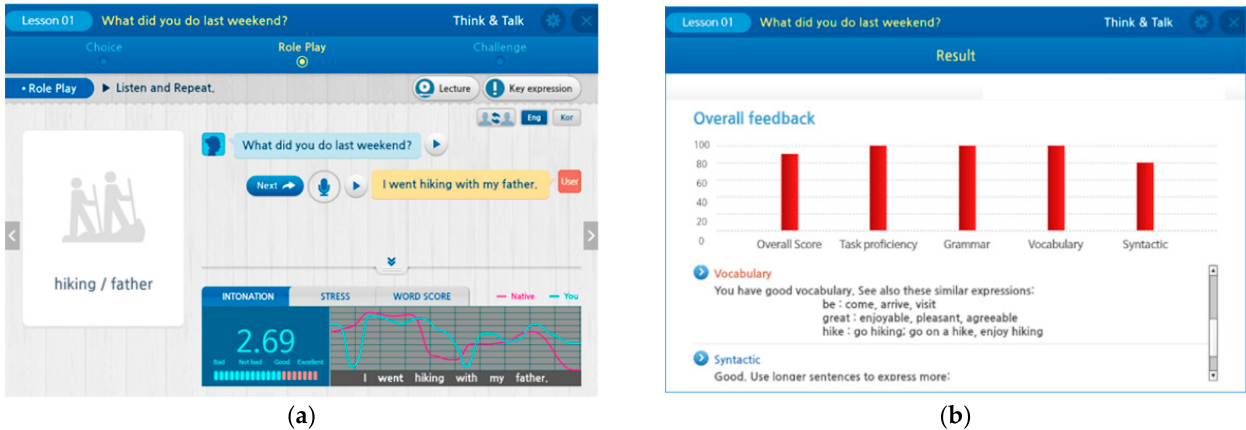
Figure 2. Example of a role-play scenario and the overall feedback. ( a ) Example of a role-play dialogue exercise and intonation feedback of the learner with the native speaker. ( b ) Overall feedback of the role-play dialogue exercise.